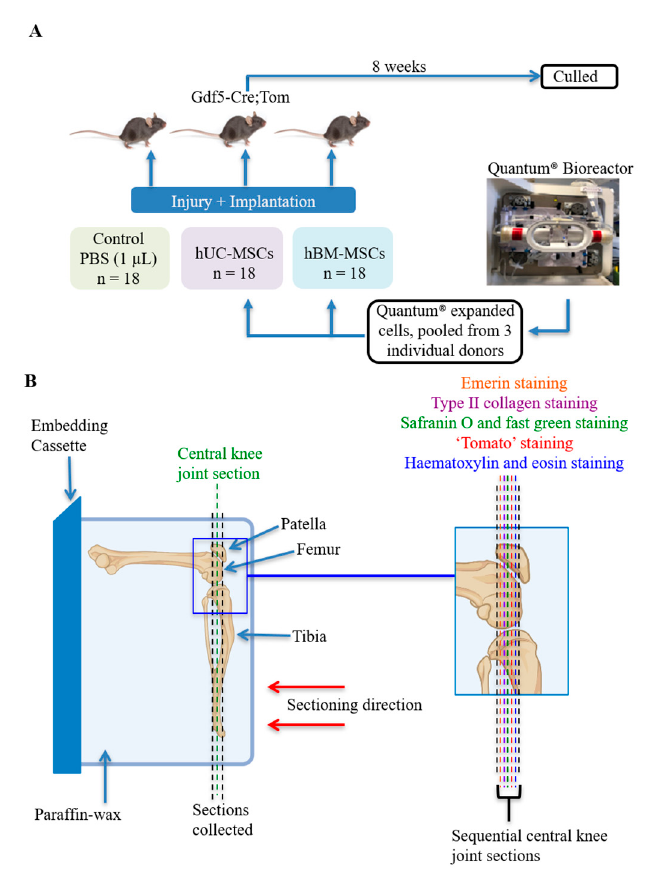
Figure 1. A schematic to show the joint surface injury (JSI) experimental design and histological staining process (partially created using Biorender.com (accessed on 15 May 2021)). ( A ) At the time of injury, Quantum-expanded human BM-MSCs or human UC-MSCs (2 × 10 5 cells in 1 µL of PBS) were implanted, unless the mice were in the vehicle control group, in which case they received PBS alone. The mice were culled after 8 weeks. ( B ) The orientation of paraffin-embedded murine knee joints in the JSI model. The knee joint sections were cut as indicated, with sequential central knee joint sections being stained with safranin O and fast green, haematoxylin and eosin, or antibodies against type II collagen, emerin or